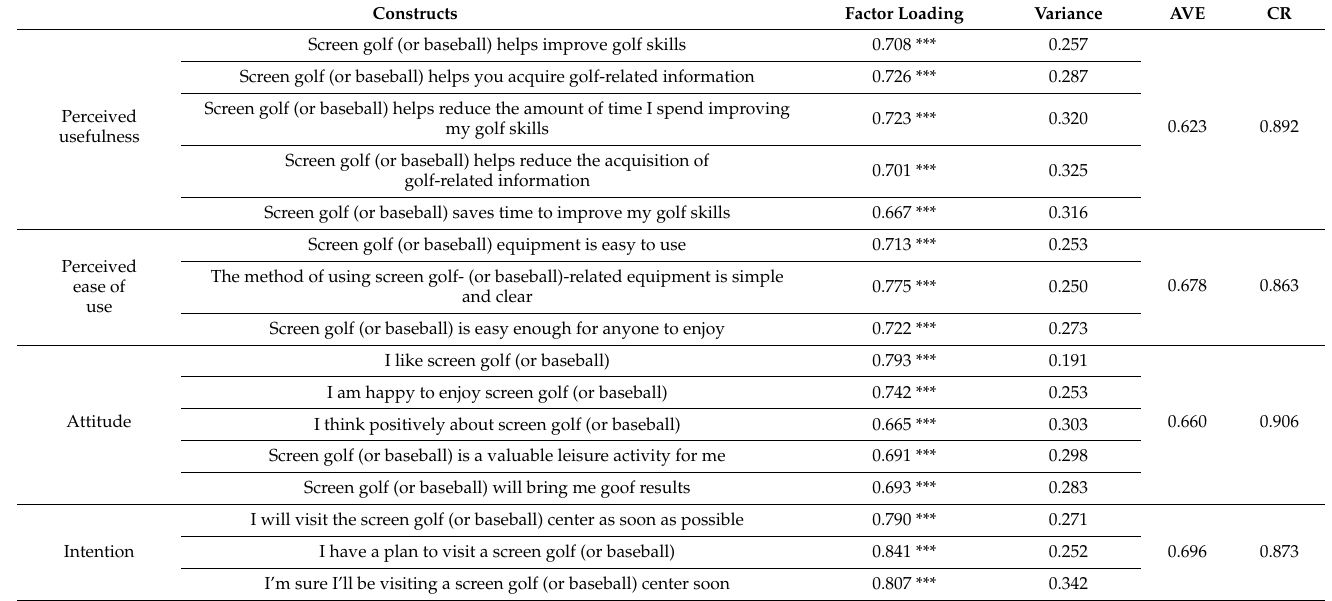
Table 2. Results of confirmatory factor analysis.